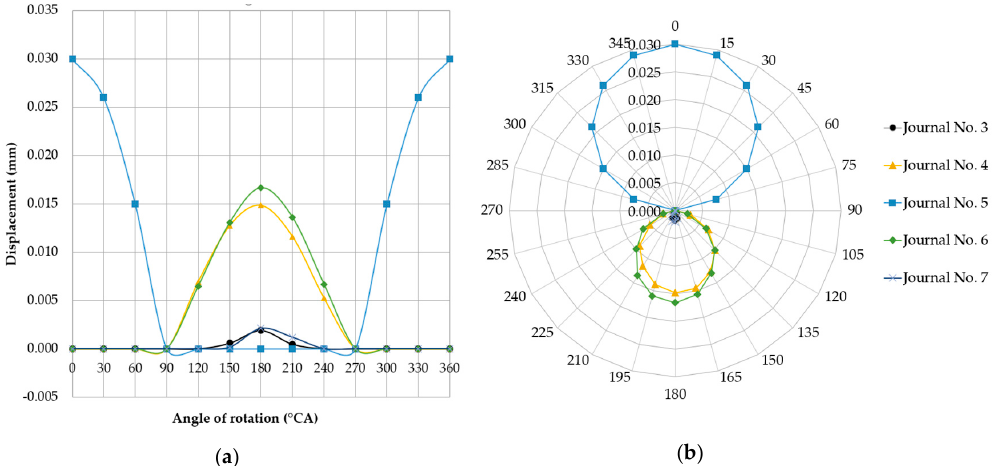
Figure 10. Changes in deflections measured in the vertical plane at individual main journals with the shaft changed by 15° at a time, and when one of the main journal axes (of journal no. 5 counting from the timing gear end) was offset eccentrically upwards by 0.03 mm relative to the others, shown in the ( a ) Cartesian and ( b ) polar coordinate systems.